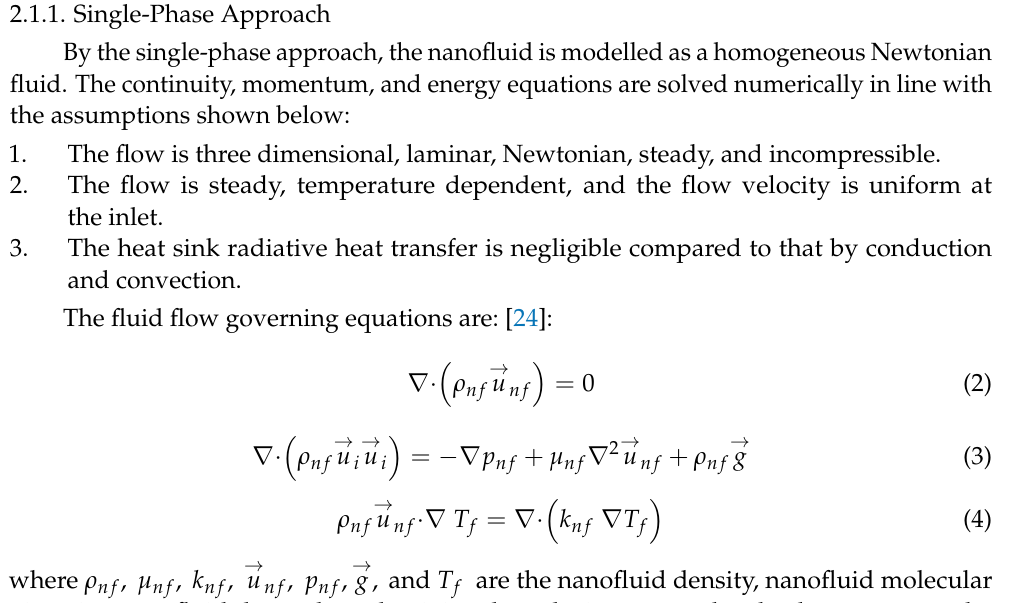
Figure 1. ( a ) Isometric schematic of the rectangular minichannel heat sink and ( b ) front view of the minichannel heat sink. The heat flux direction is indicated by the up-pointing